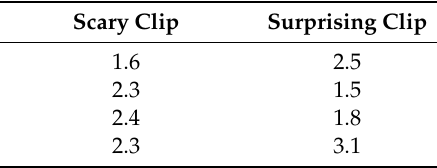
Figure 1. Three-point moving averages of facilitation indices for the Joy word set whilst viewing the Joy movie clip. Positive scores imply participants were experiencing joy, negative scores imply they were experiencing the opposite (sadness). The start points of each of the six scenes are indicated, as well as their peak indices and a brief description of the content at that point in time. Analysis indicated that the facilitation indices at the seconds 8, 14, 16, 24 – 28, 34 − 38, and 48 − 52 (all of the peaks) are